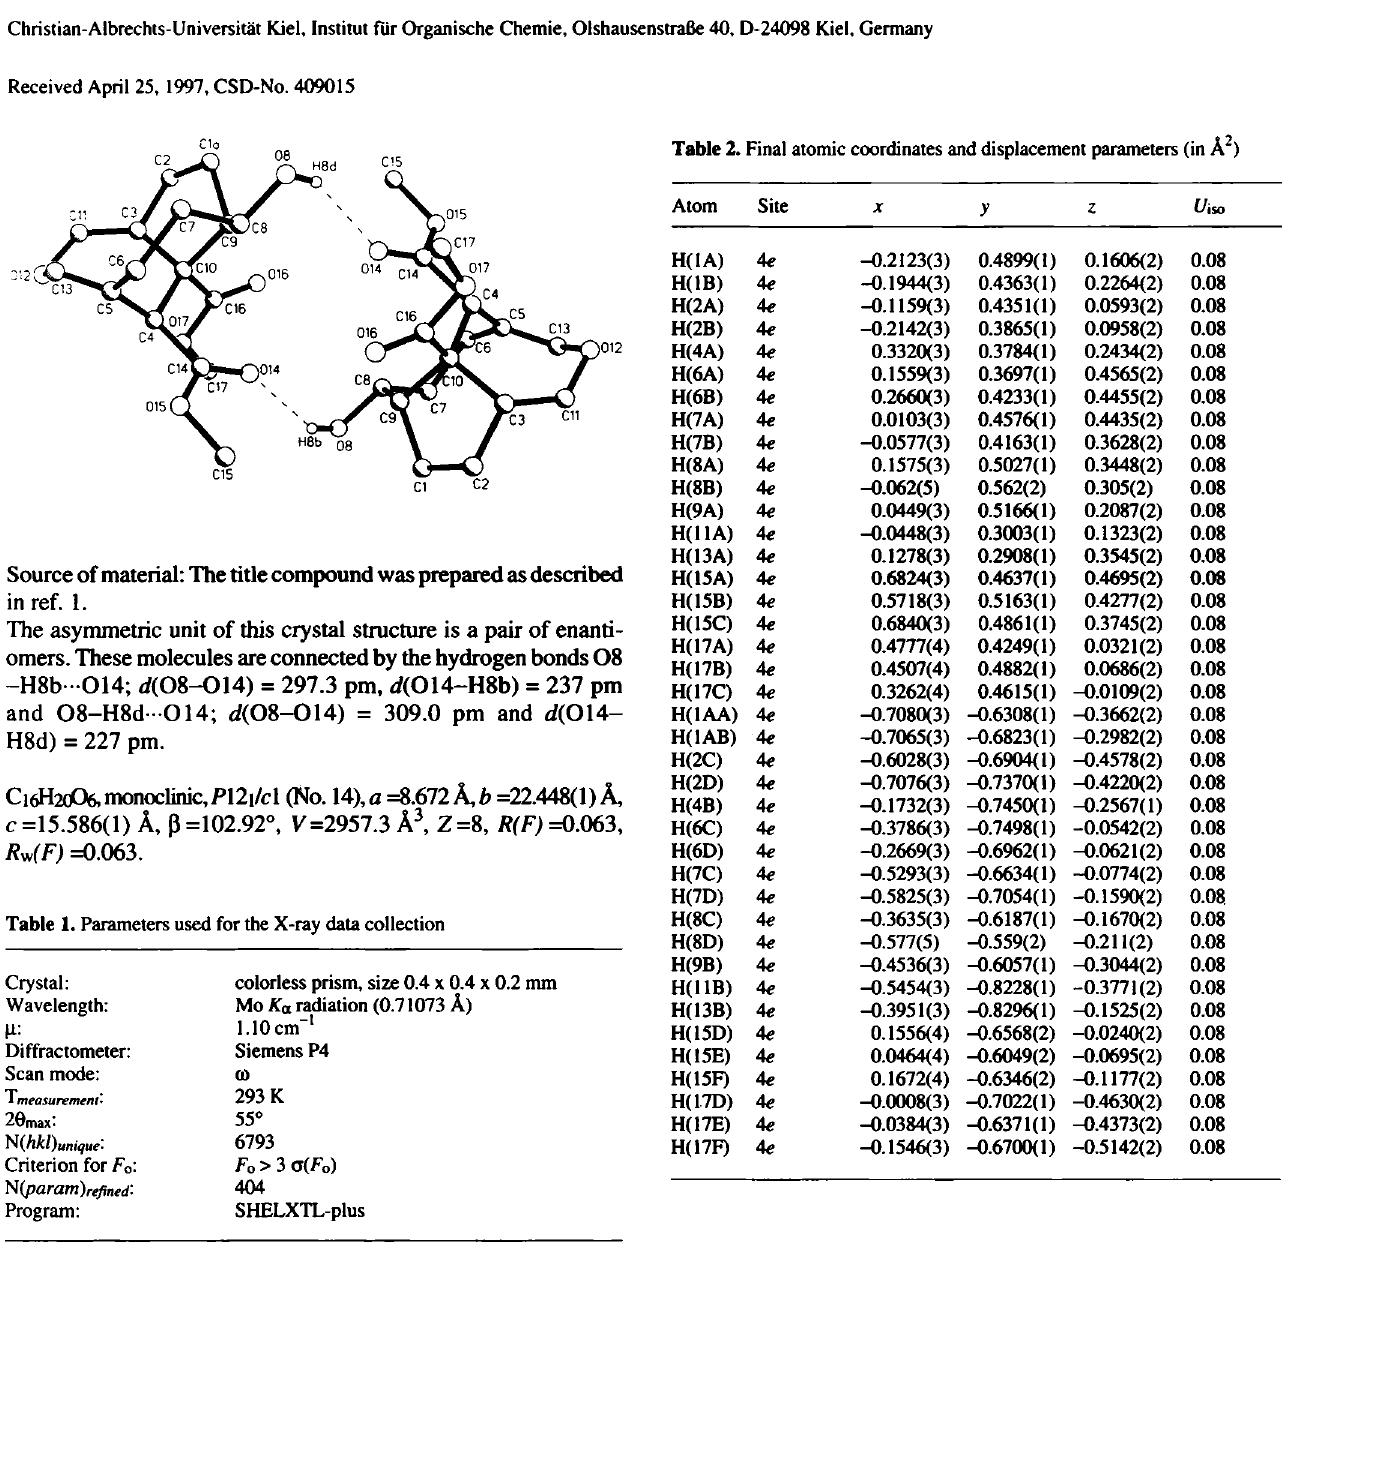
Table 2. Final atomic coordinates and displacement parameters (in